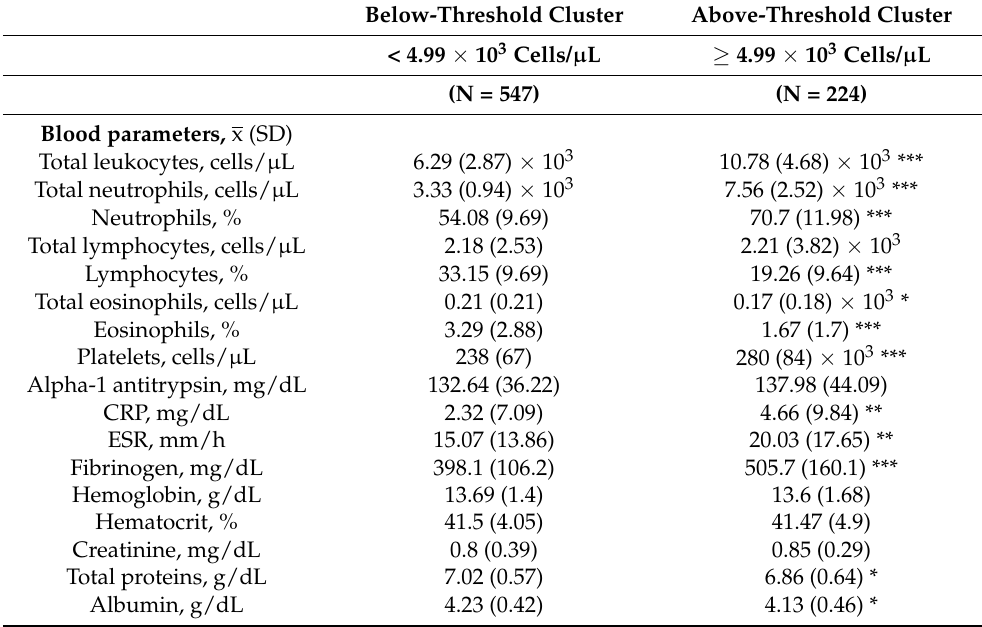
Table 7. Inflammatory and nutritional parameters in the two clusters of patients, excluding those with chronic colonization by